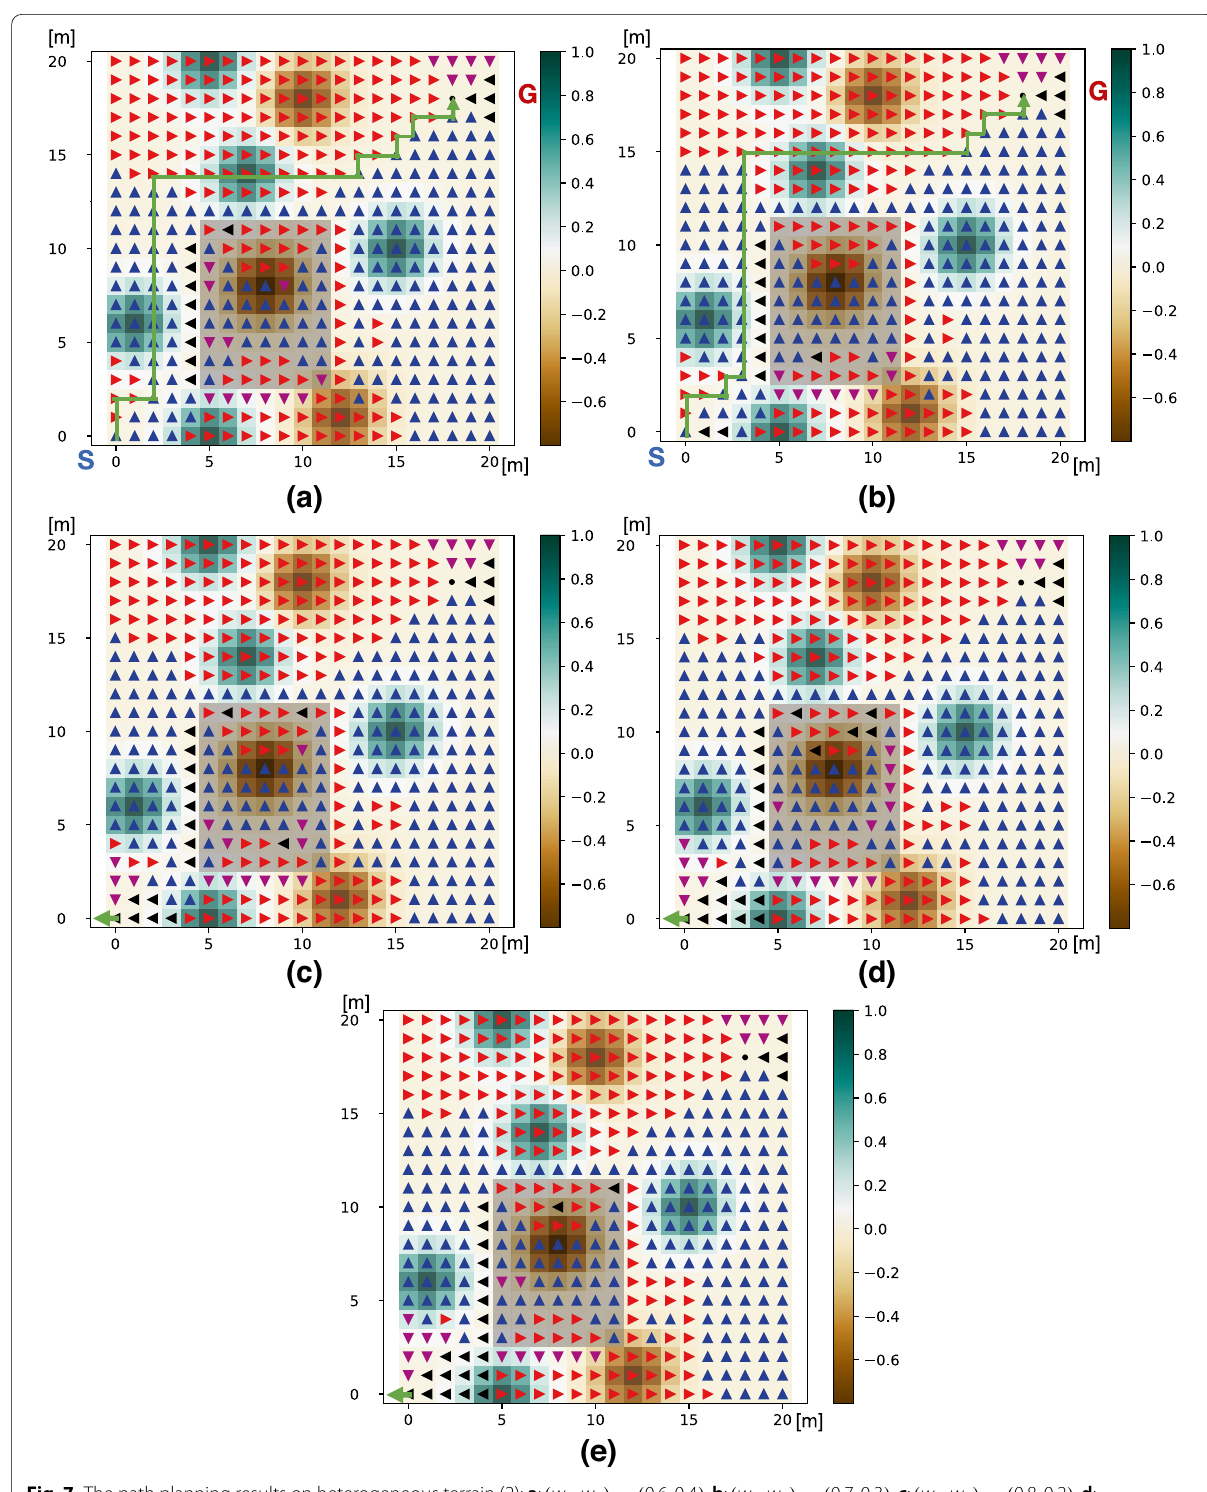
Fig. 7 The path planning results on heterogeneous terrain (2); a : ( w 1 , w 2 ) = ( 0.6,0.4 ) , b : ( w 1 , w 2 ) = ( 0.7,0.3 ) , c : ( w 1 , w 2 ) = ( 0.8,0.2 ) , d : ( w 1 , w 2 ) = ( 0.9,0.1 ) , e : ( w 1 , w 2 ) = ( 1,0